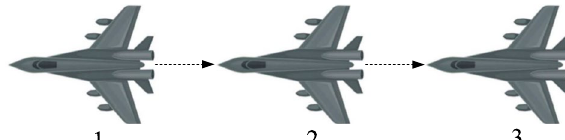
Fig. 1 Structural model of group